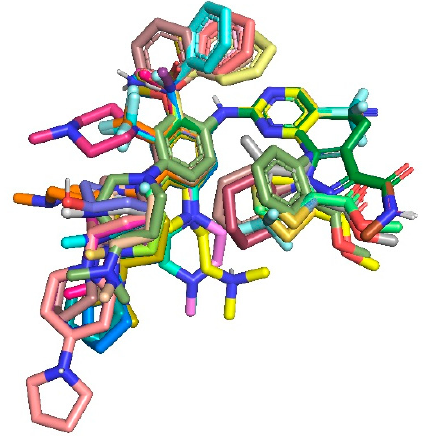
Figure 4. Alignment of the dataset compounds for hybrid 3D-QSAR.